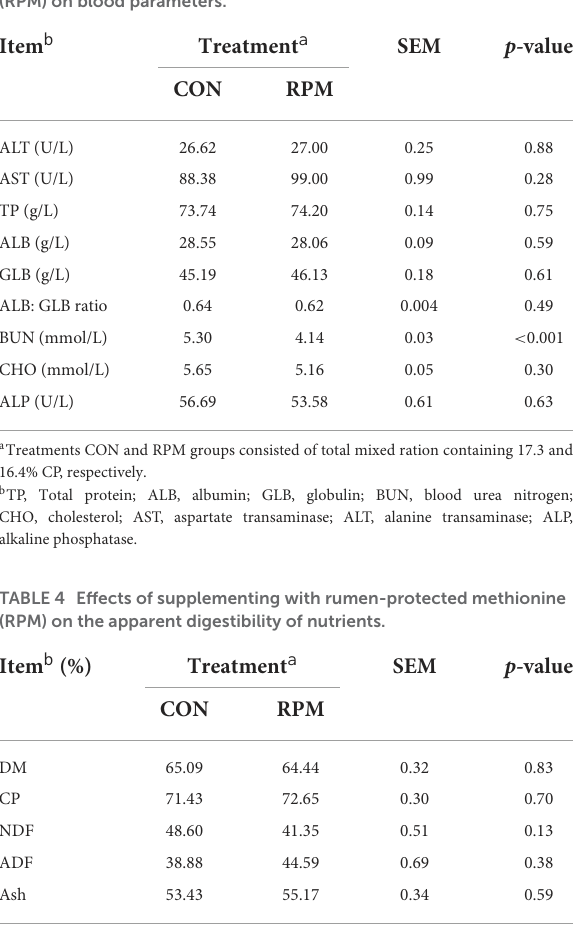
TABLE 3 Effects of supplementing with rumen-protected methionine (RPM) on blood parameters.